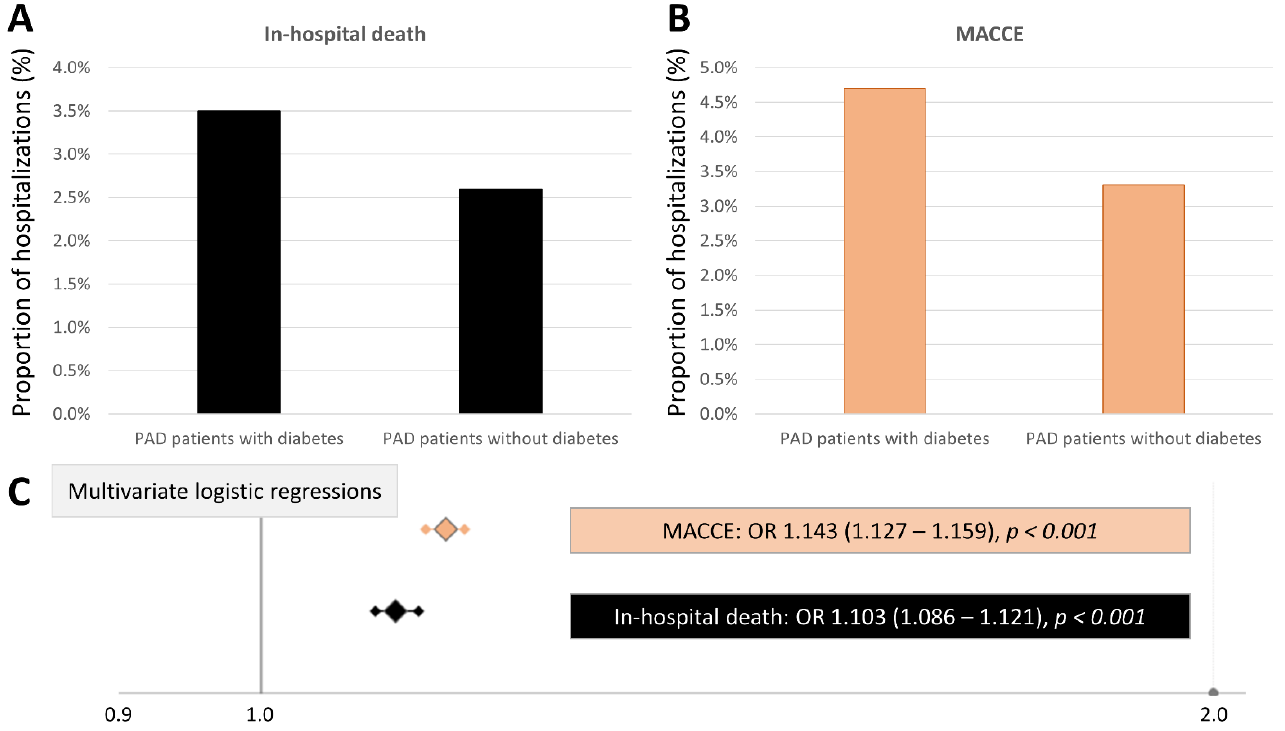
Figure 1. DM affecting in-hospital mortality and MACCE during hospitalizations of PAD patients. ( A ): Comparison of in-hospital mortality of PAD patients stratified for DM. ( B ): Comparison of MACCE rate of PAD patients stratified for DM. ( C ): Multivariate regression models identifying an independent association of DM with in-hospital death as well as MACCE in PAD patients (adjustment II).